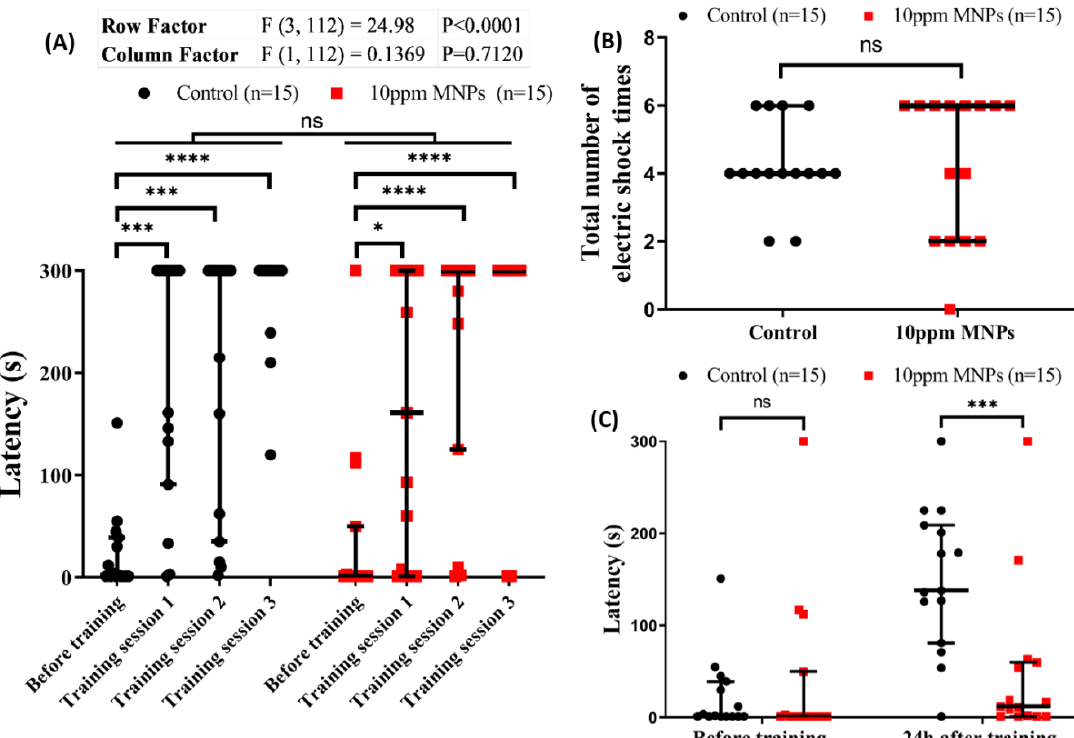
Figure 8. Passive avoidance test on zebrafish after 14 days of Fe 3 O 4 MNPs exposure to evaluate short-term memory. ( A ) The latency of control (black) and MNPs-exposed (red) group in the dark chamber with electric shock punishment before and during training. ( B ) Total number of electric shocks given to zebrafish until passing the training session. ( C ) The latency of control (black) and MNPs-exposed (red) groups in the dark chamber with electric shock punishment before and one day after a training session. The data are expressed as the median with an interquartile range and significance were analyzed by a two-way ANOVA test ( n = 15, * p < 0.05, *** p < 0.001, **** p < 0.0001). 3.9. MNPs Exposure on Ferric (Metal) Content, Reactive Oxygen Species (ROS), and Stress Hormones in the Brain